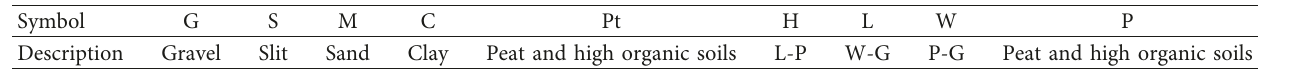
Table 5: Symbols are used for identifying the soil types.